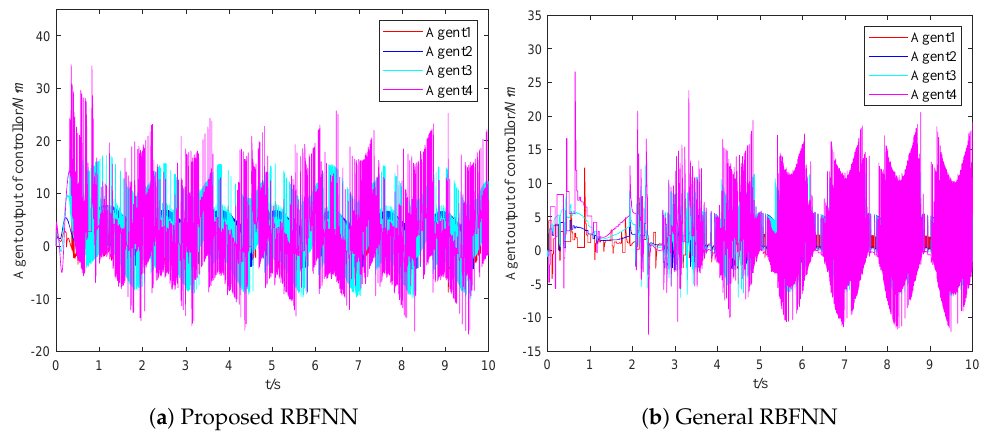
Figure 5. The comparison of the controllers.